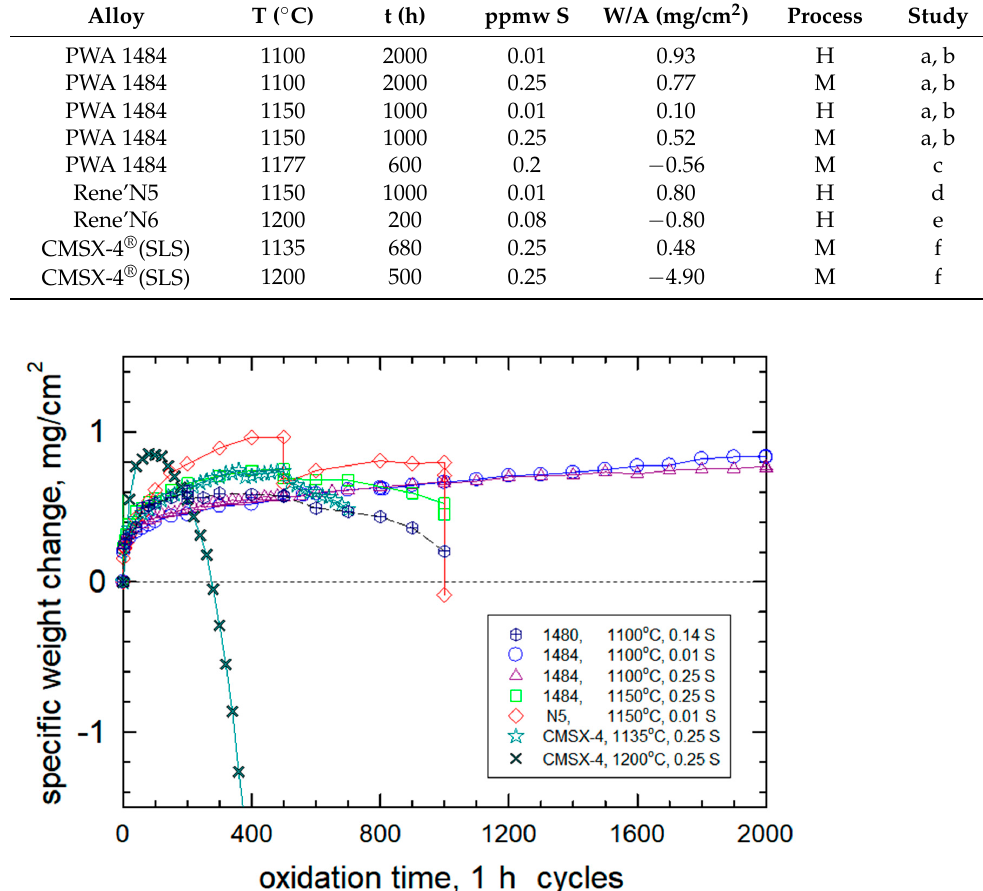
Figure 5. Representative cyclic oxidation curves for highly oxidation-resistant low sulfur 2nd generation single-crystal superalloys compared to PWA 1480 average behavior (1100 ◦ C–1200 ◦ C, 500–2000 h, 0.01–0.25 ppmw S). The hydrogen-annealed samples are compared and similar to, for example, melt desulfurized 0.2 ppmw S PWA 1484 after 500 h oxidation at 1177 ◦ C ( − 0.56 mg/cm 2 )